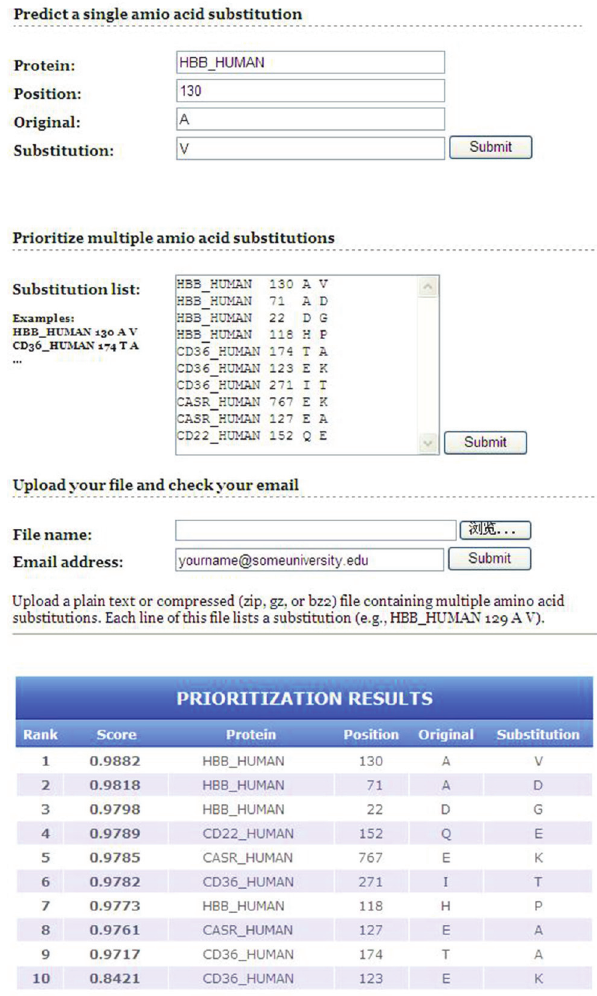
F 1: Web interface of